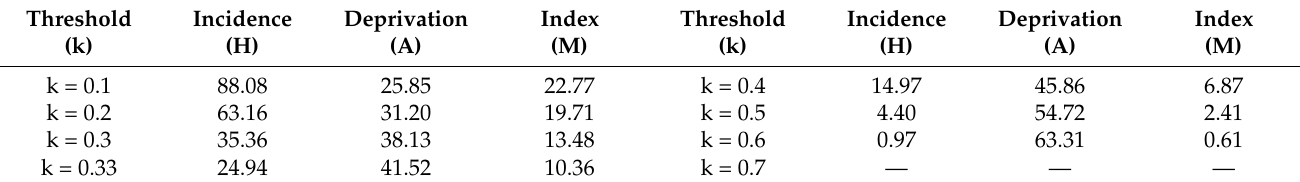
Table 3. Multidimensional poverty of rural households at different thresholds